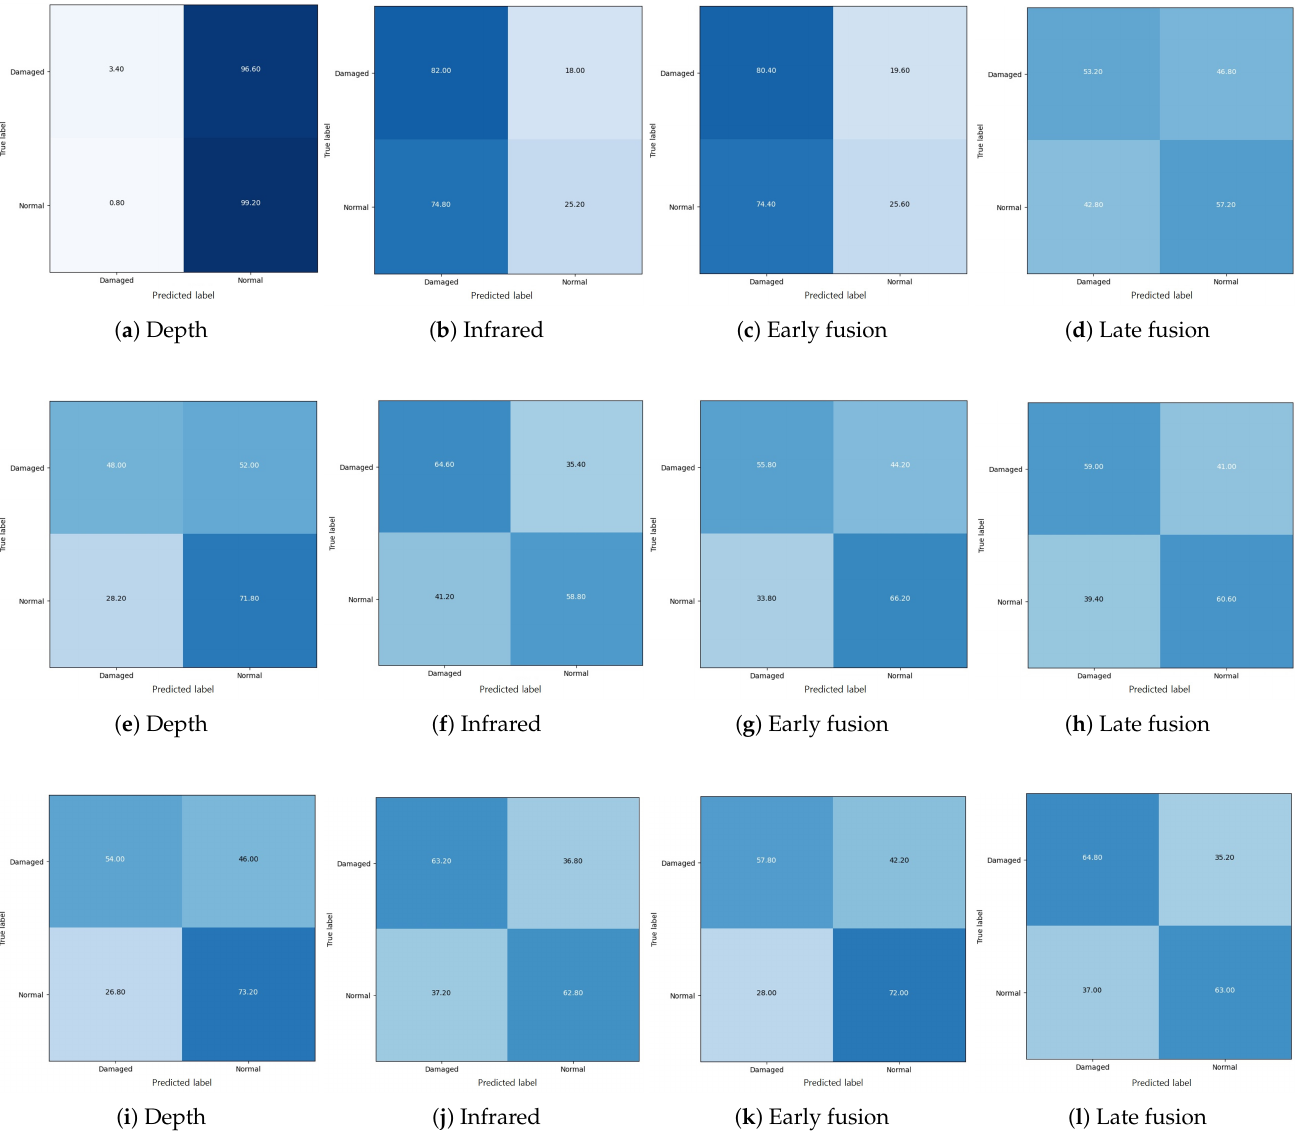
Figure A2. Confusion matrix with 10% of training data: the first, second, and third row indicate the confusion matrices from the Supervised, transfer supervised , and transfer SSL approaches,